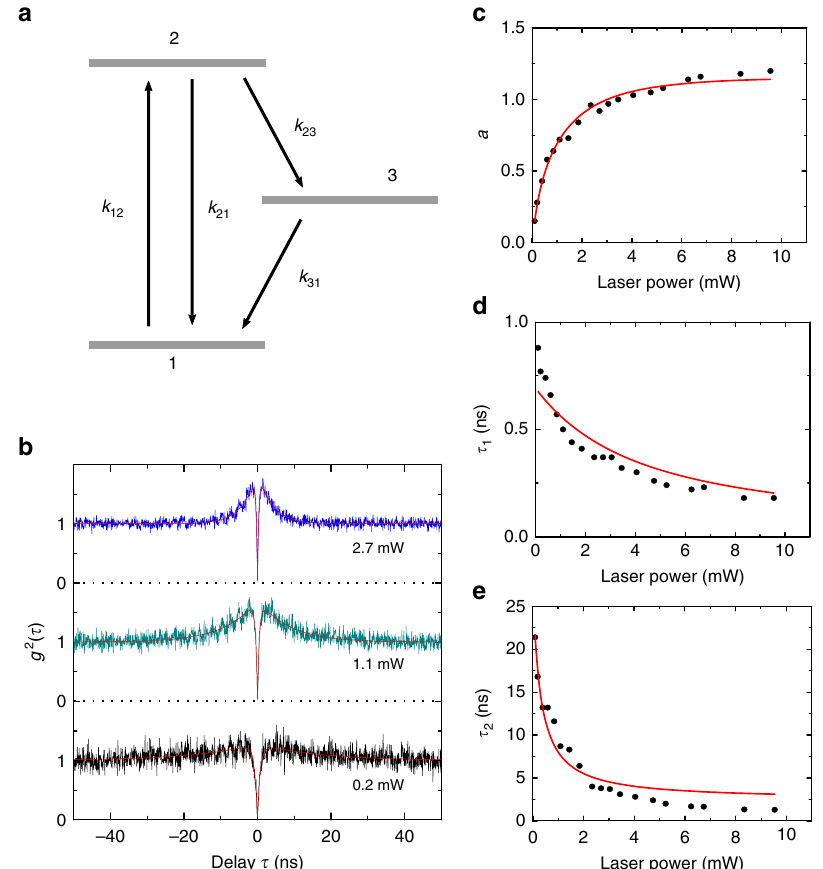
Fig. 3 Energy level analysis for SPEs. a Three-level model of the SPEs with ground state |1> , excited state |2> , and metastable state |3> . The parameter k 12 is the excitation rate from ground state |1> to excited state |2> , and other k ij parameters represent the decay rate from state | i > to | j > , where i , j are number from 1 to 3. b Three representative CW second-order autocorrelation function measurements with different laser excitation powers. The red lines are the fi tting using the Eq. (1). c , d , e The fi tting parameters a , τ τ 1 and 2 of the antibunching curve as a function of excitation power. The red lines are the the